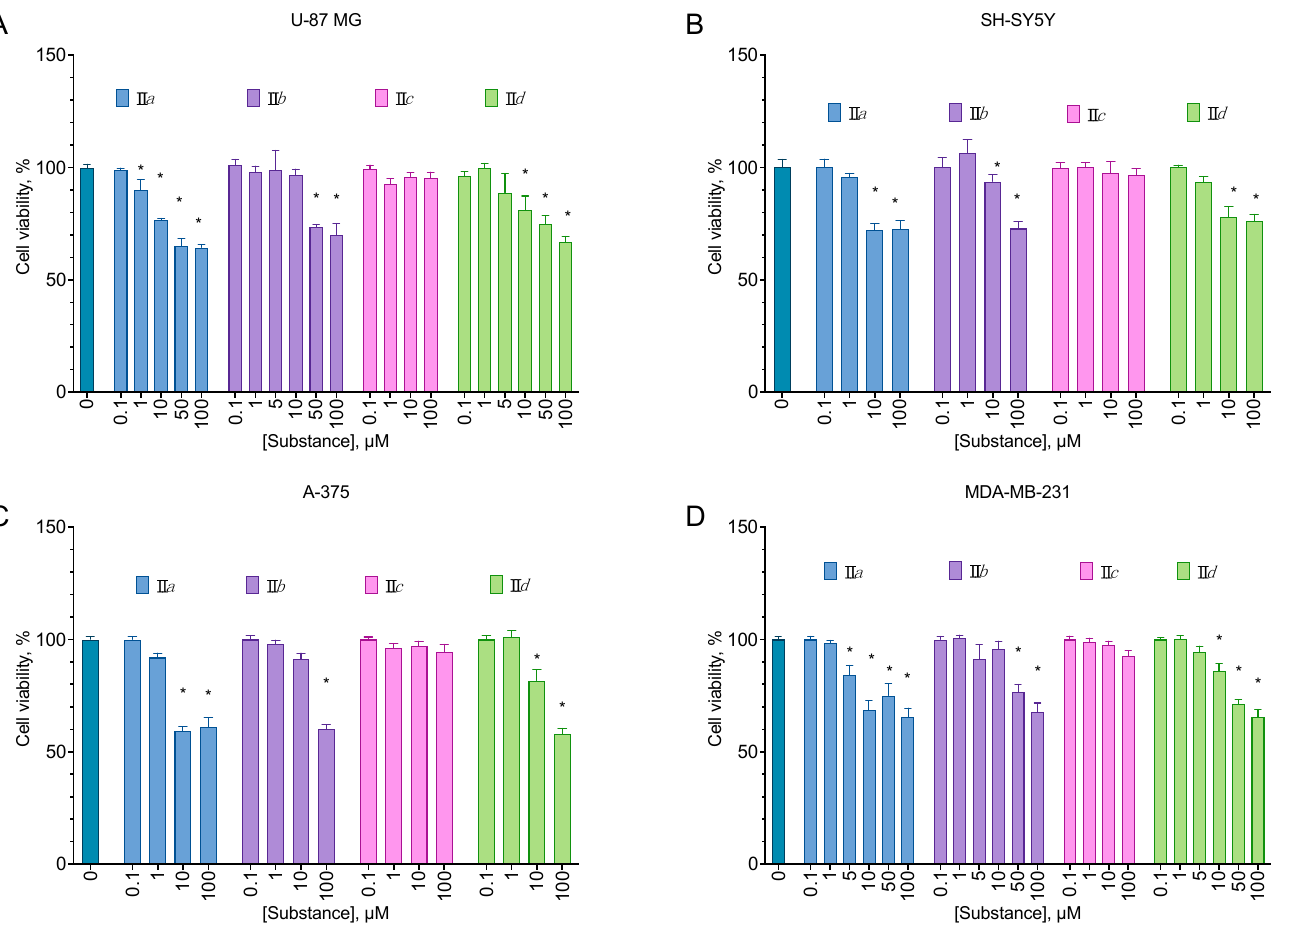
Figure 3. Anti-proliferative activity of the aryl carbamates for the U-87 MG glioblastoma ( A ), SH-SY5Y neuroblastoma ( B ), A-375 melanoma ( C ), and MDA-MB-231 carcinoma ( D ) cell lines. Negative control cells (100% viability) were treated with 0.5% DMSO. Positive control cells (100% cell death) were treated with 3.6 µL of 50% Triton X-100 in ethanol per 200 µL of the cell culture medium. 24 h incubation. MTT test data. Mean ± standard error ( n = 5 experiments). * Statistically significant difference from the control, ANOVA with the Dunnett post-test, p ≤ 0.05